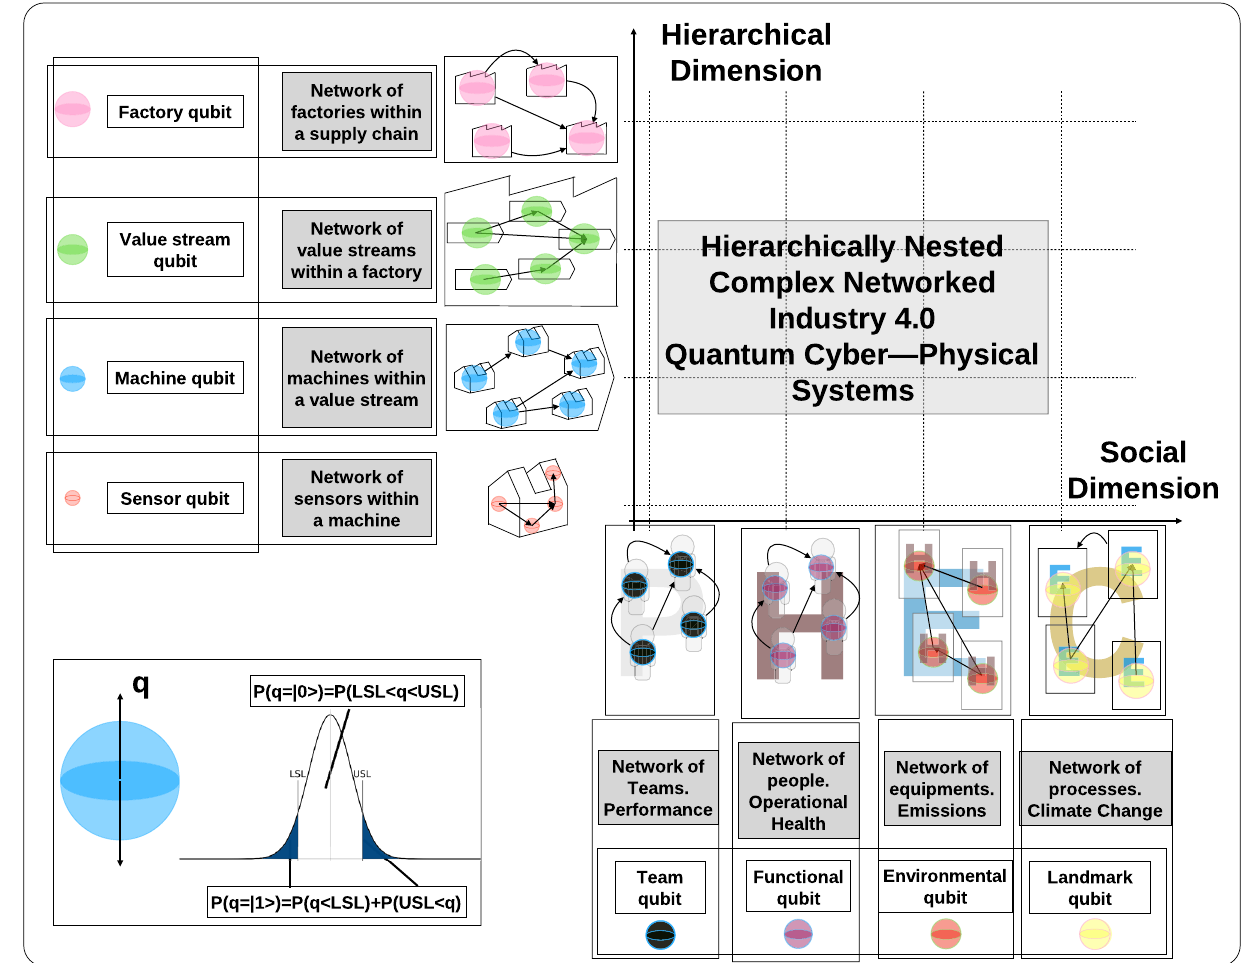
Figure 1. Quantum industry 4.0 cyber-physical